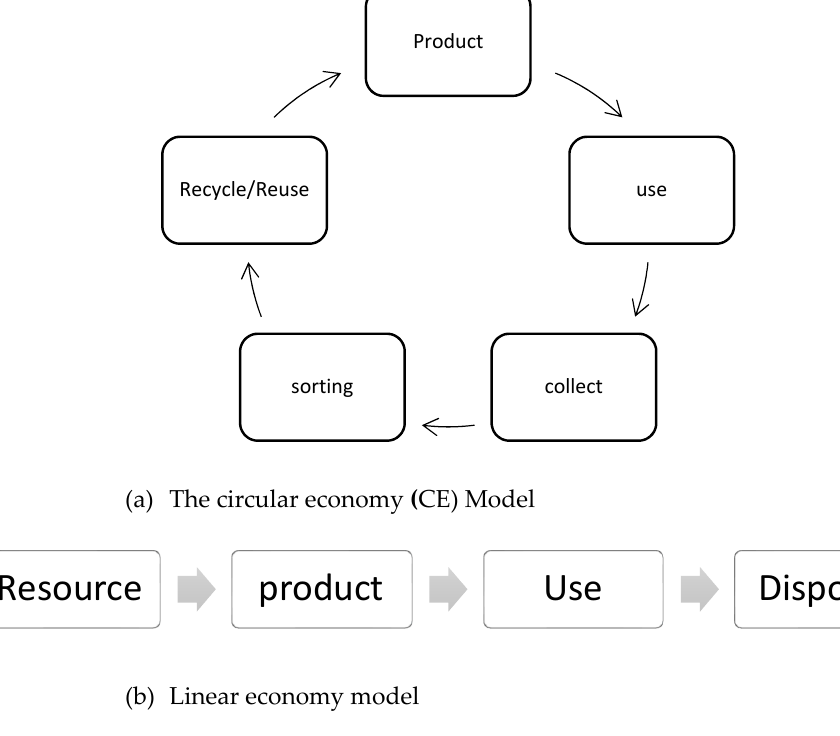
Figure 1. Circular economy (CE) model versus Linear economy model. ( a ) is labelled CE model and ( b ) linear economy model.